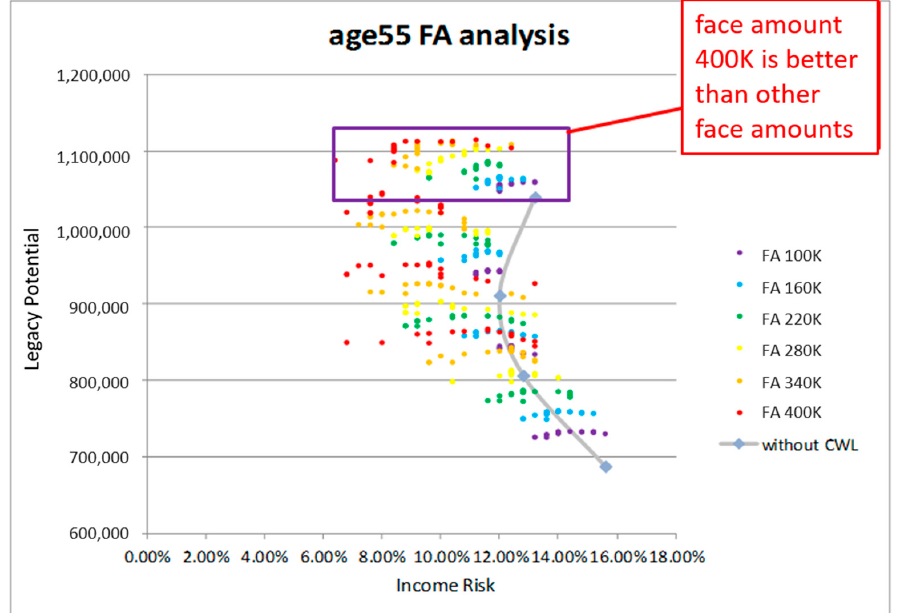
Figure 4. Analysis of face amounts.